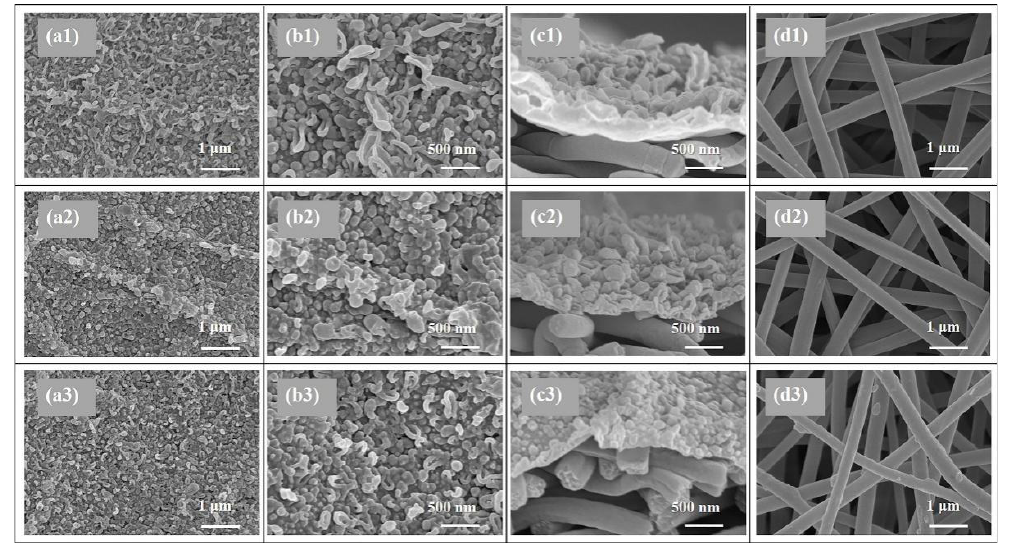
Figure 2. SEM images of the nanofiber-supported TFC FO membranes prepared via different heat-curing methods: ( a1–d1 ) n-TFC; ( a2 – d2 ) o-TFC; ( a3 – d3 ) n-TFC; ( a1–3 , b1–3 ) active layer; ( c1–3 ) cross-section; ( d1–3 ) support layer.